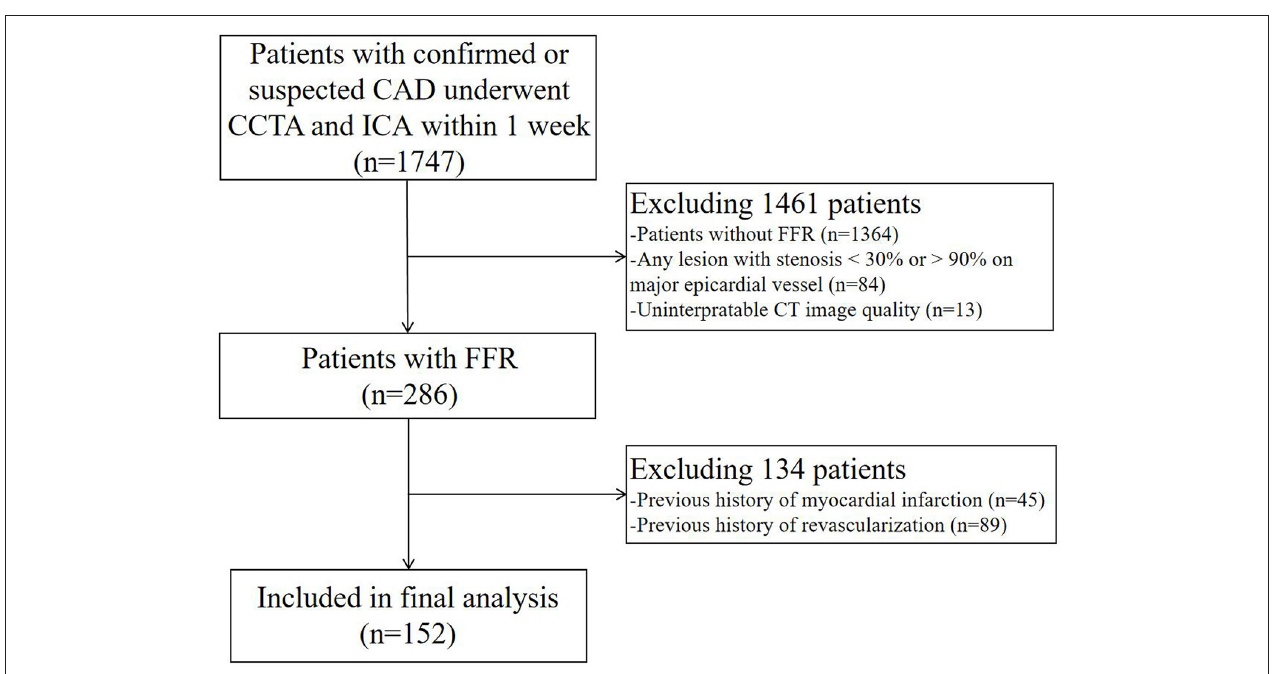
FIGURE 1 | Flowchart of patient selection. CCTA, coronary computed tomography angiography; ICA, invasive coronary angiography; FFR, fractional flow reserve; CT, computed tomography.